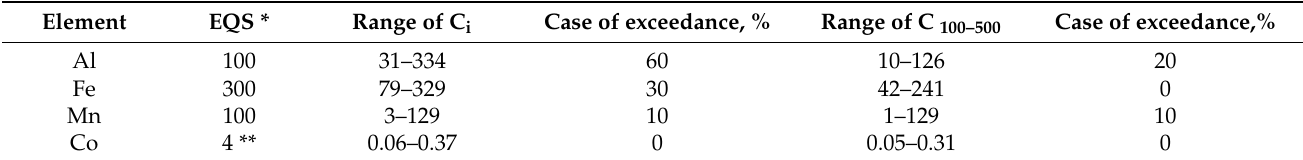
Table 4. Exceedance of EQS for filterable forms of Al, Fe, Mn, and Co by concentration ( µ g/L) without clogging influence (C i ) and after clogged membranes (C 100–500